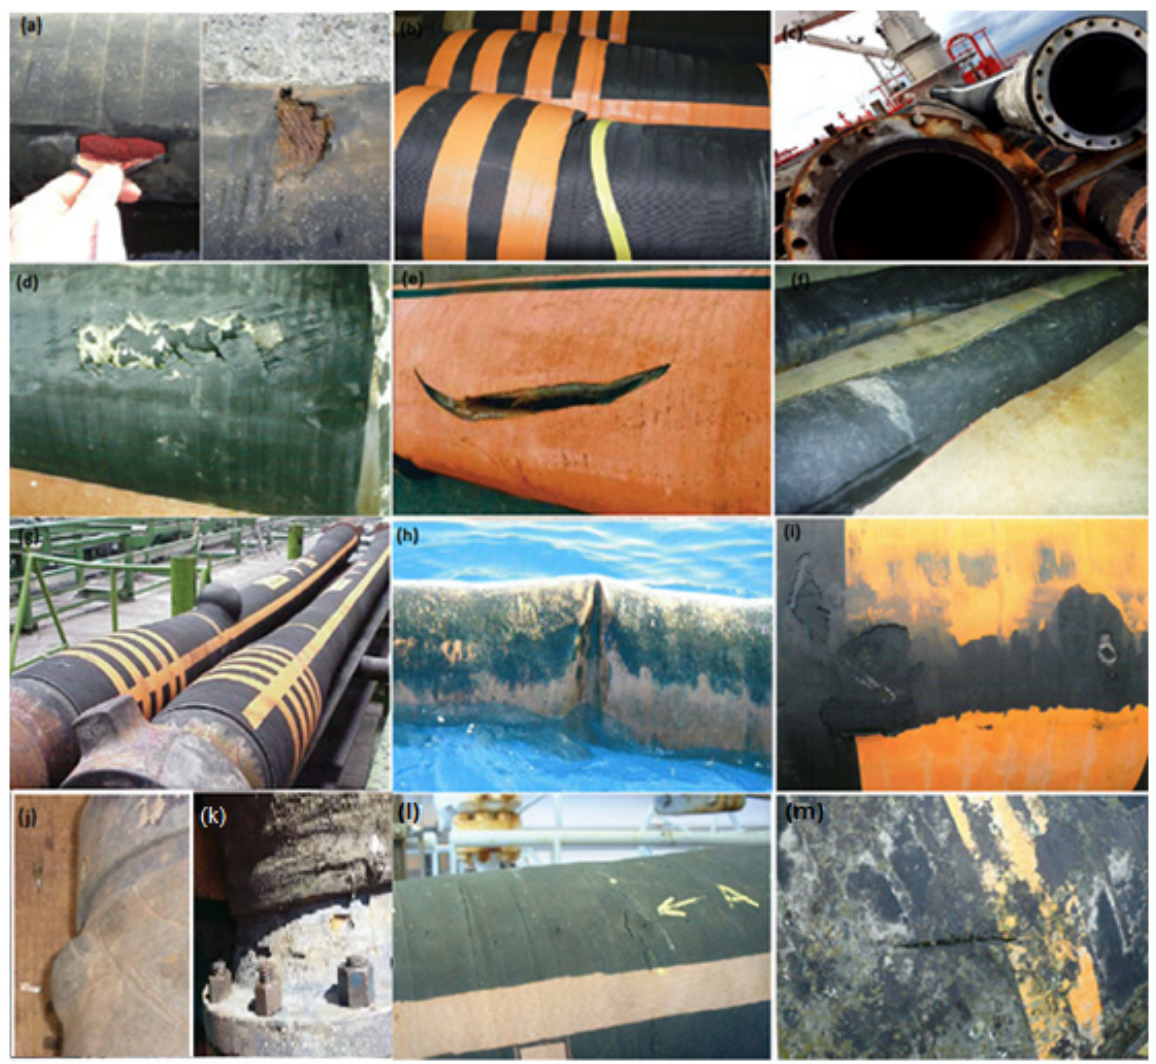
Figure 32. Image collage of some hose failure modes, showing ( a ) hose cover failure for repair and beyond repair with exposed reinforcement, ( b ) hose cover damage, ( c ) heavy wear of the hose flange after 14 years-service, ( d )abrasion damage on hose, ( e ) floating hose after a propeller cut ( f ) crushed 16 inches submarine hoses after excessive load landed on it, ( g ) Pressure test with leaking liner, ( h ) hose wall damage due to hose kinking, ( i ) cover abrasion damage down to breaker fabric, ( j ) bonding defect near end-fitting detected in pressure test, ( k ) excessive external corrosion on hot dip galvanised nipple after 3 years-service in offshore Vietnam, ( l ) cracking in outer cover of hose, and ( m ) hose damage for repair showing cut on cover (Sources: [36–41], Courtesy: Trelleborg & ContiTech).